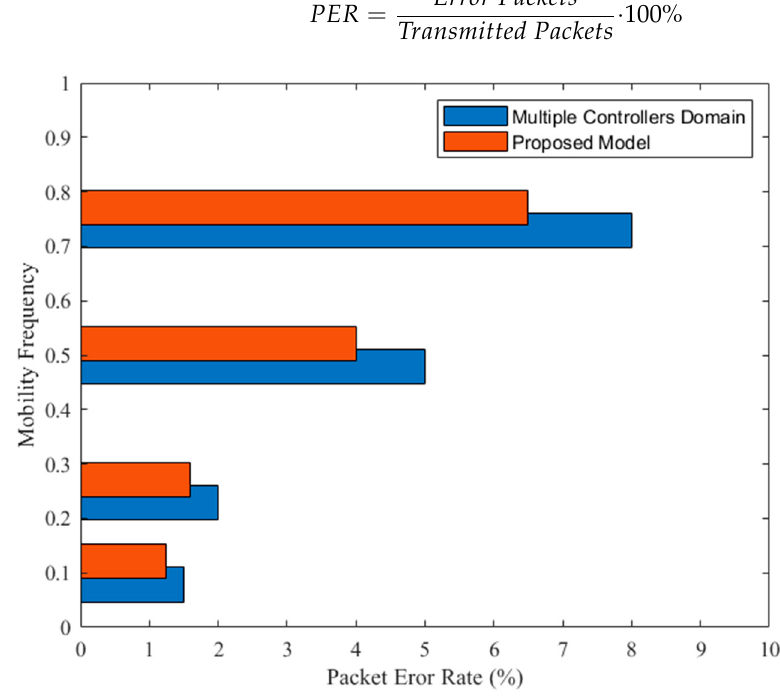
Figure 12. Packet error rate (PER) comparison of proposed architecture.